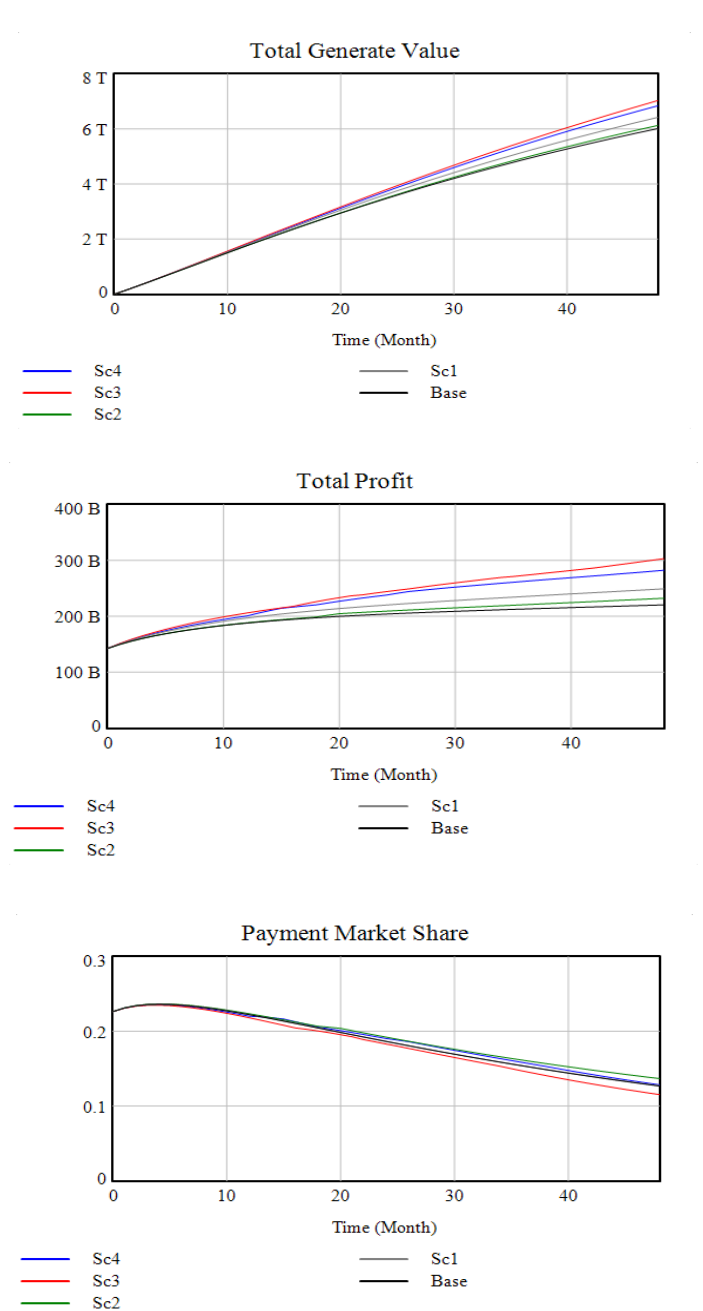
Figure 5. Detailed Analysis of studied case’s scenarios for resource allocation with respects to systemic PPM